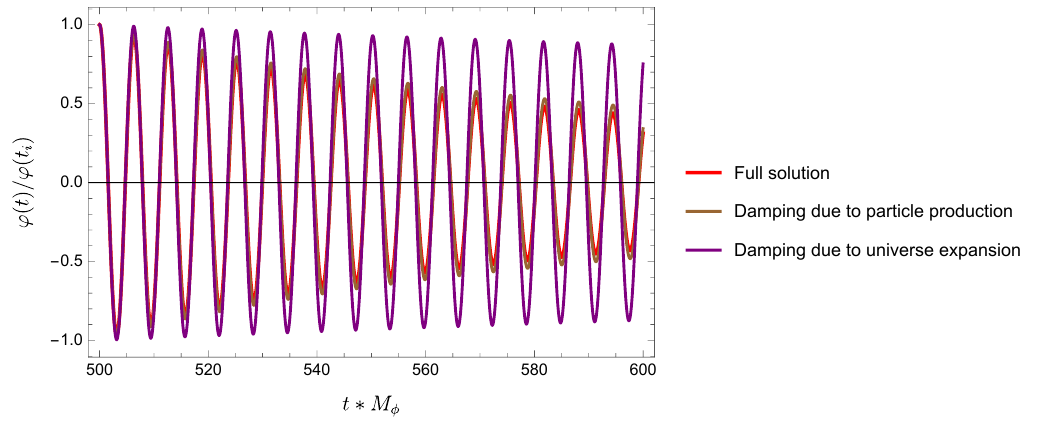
Figure 6 . Same as figure 5 but now with the initial time t i M φ = 500